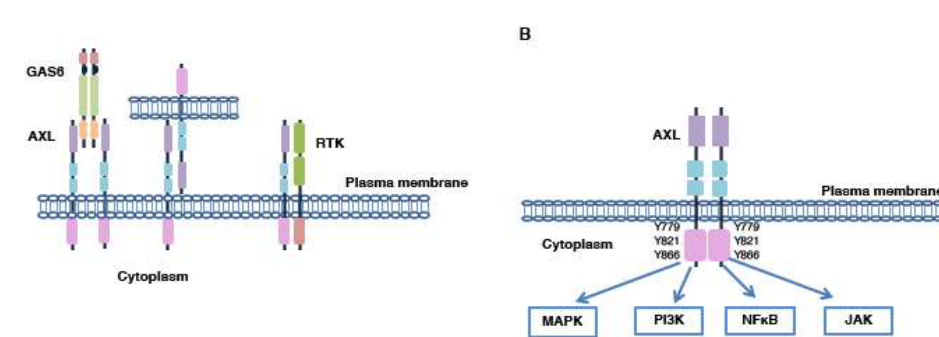
Figure 3. AXL activation. ( A ) AXL can be activated in several ways: (1) ligand-dependent dimerization; (2) ligand-independent activation mediated by interaction between two AXL monomers present on neighboring cells or with other members of the receptor tyrosine kinase (RTK) family. ( B ) AXL activation regulates many molecular pathways.